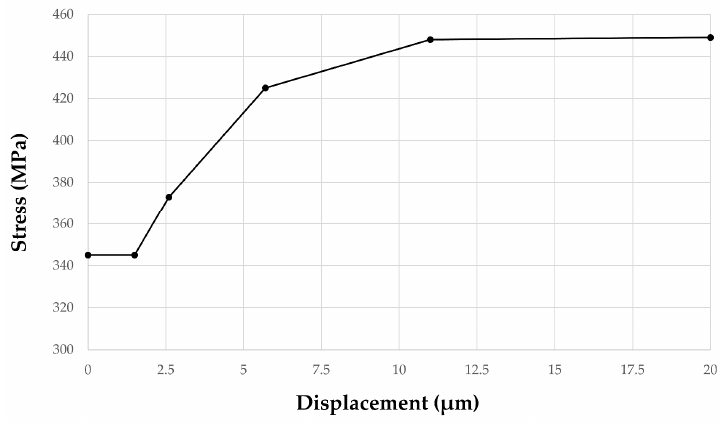
Figure 6. Multilinear curve of kinematic hardening.